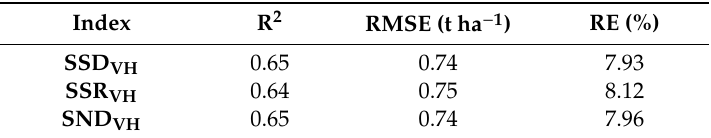
Table 2. Quantitative relationships between SAR indices and rice grain yield by the leave-one-out cross-validation (LOOCV).